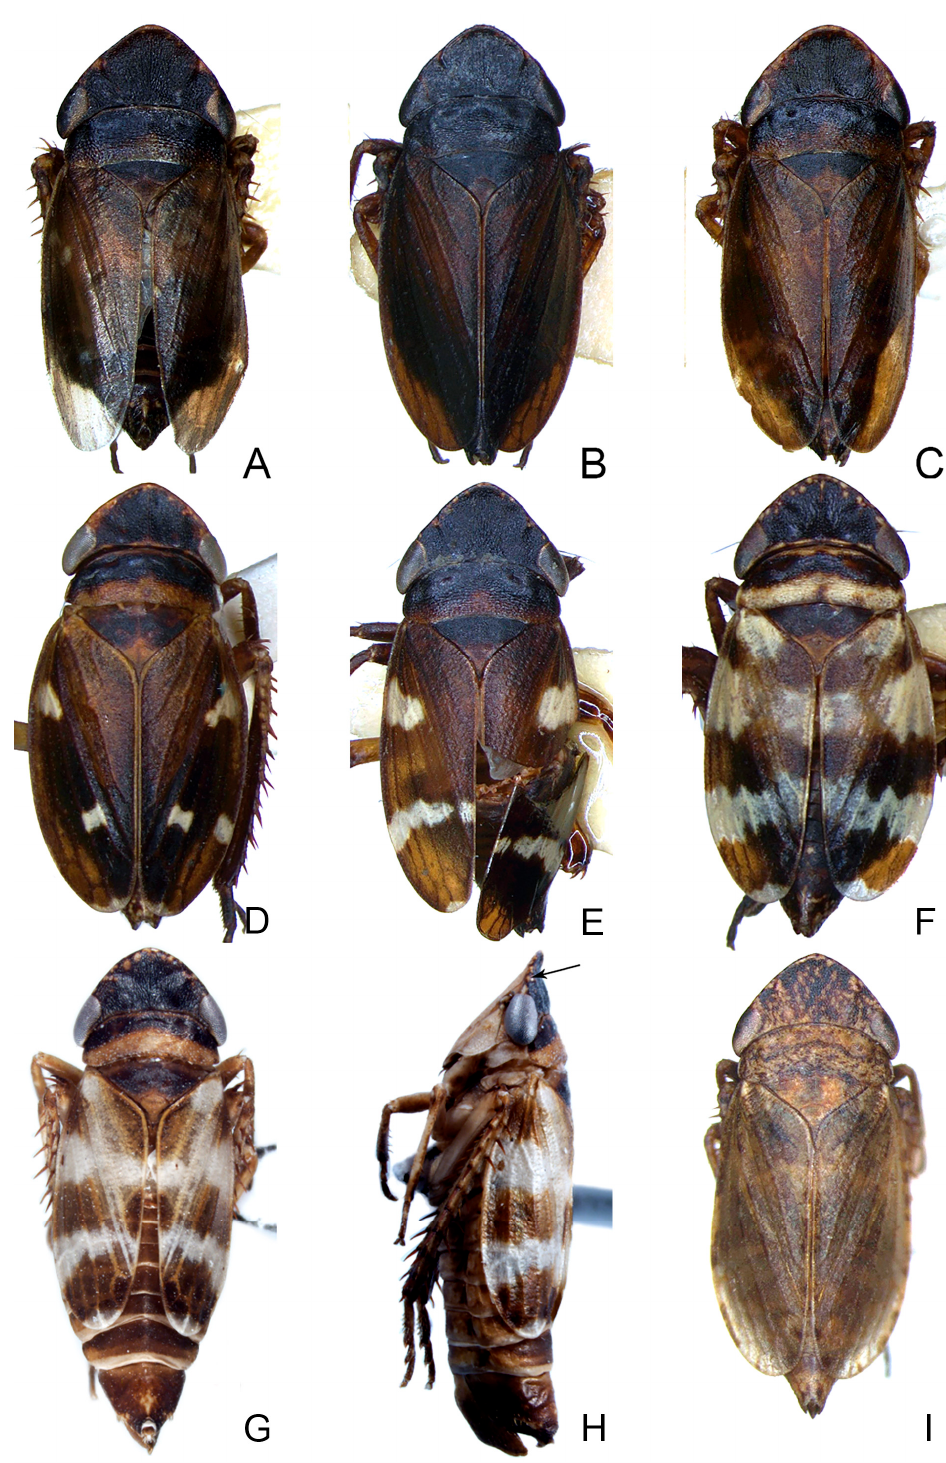
Figure 4. ( A – I ) Planaphrodes nigricans , dorsal and lateral habitus. ( A ) ♂ , Korea, Deogsungsan CN.